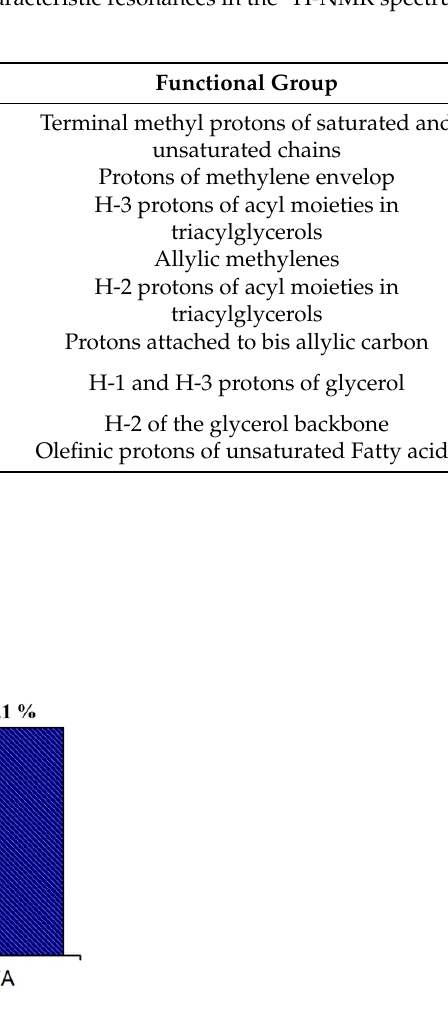
Table 2. Chemical shifts and assignments of the characteristic resonances in the 1 H-NMR spectrum of crude seed oil.